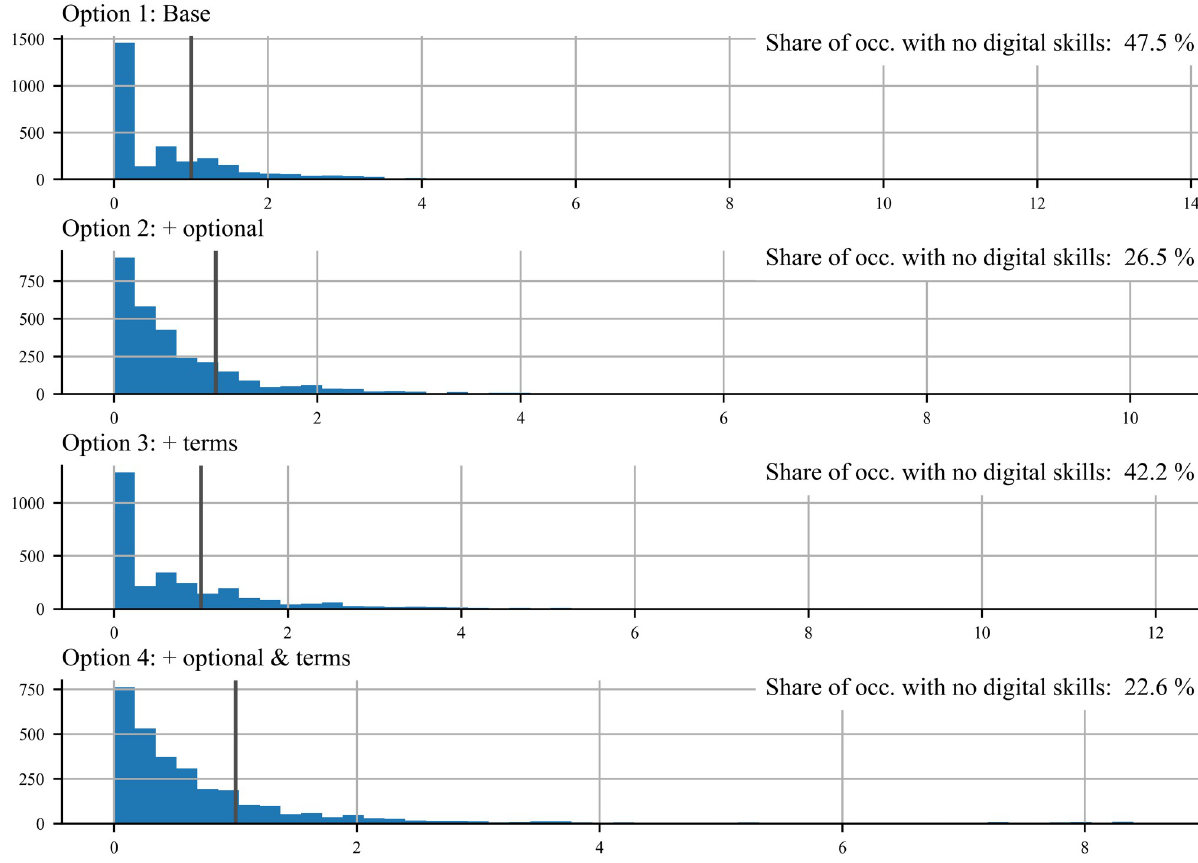
Fig 2. Distribution of DCI indicators across occupations. Note: we have added a line at value one in order to visually distinguish occupation groups with a revealed comparative advantage from those with a revealed comparative disadvantage.